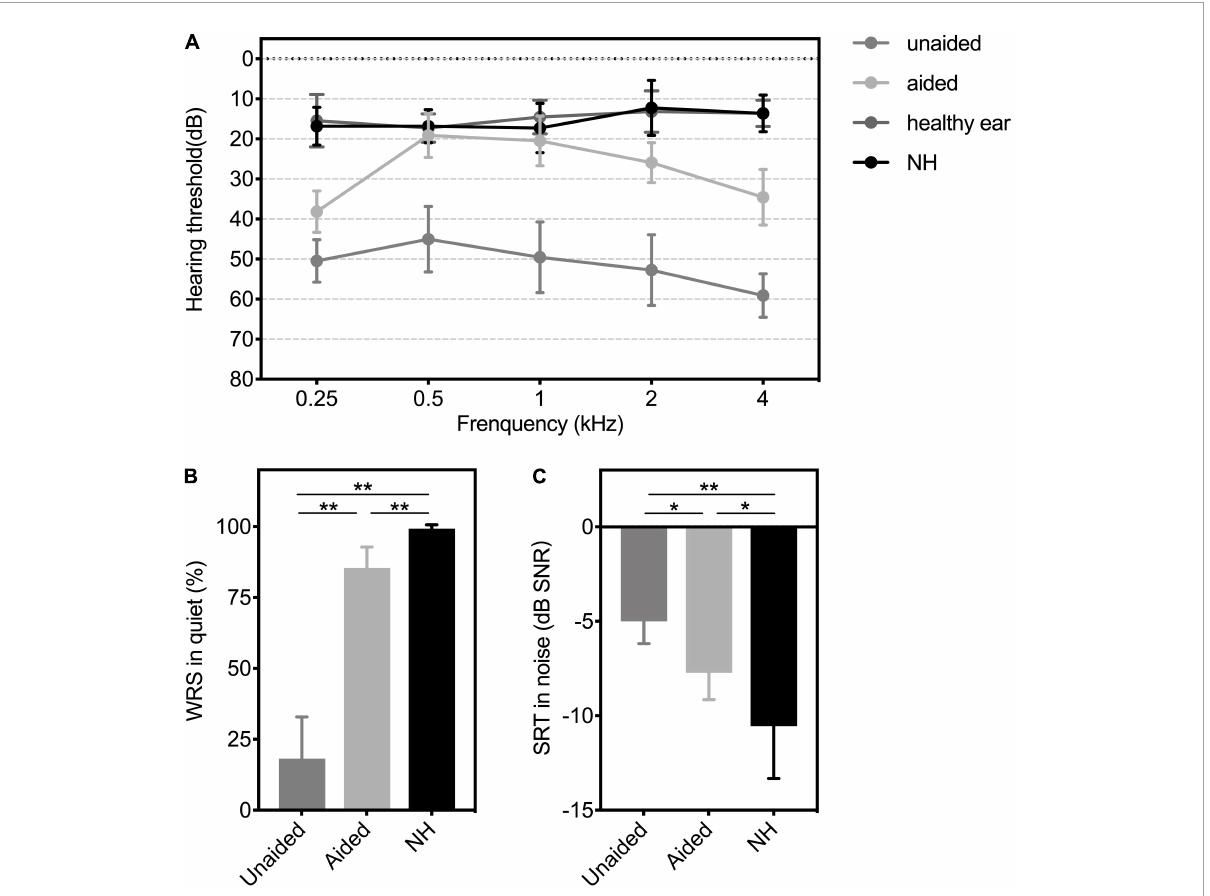
FIGURE2 (A) Hearing thresholds, (B) WRS in quiet, and (C) SRT in the noise of patients with UMA in unaided and aided conditions, as well as the controls. Group means are presented as mean ± SD . Significant differences, * p < 0.05, ** p < 0.01. WRS, word recognition score; SRT, speech reception threshold; SNR, speech-to-noise ratio; SD , standard deviation; Unaided, the unaided condition of UMA; Aided, the aided condition of UMA; healthy ear: the healthy ear of patients with UMA; NH, normal hearing group.